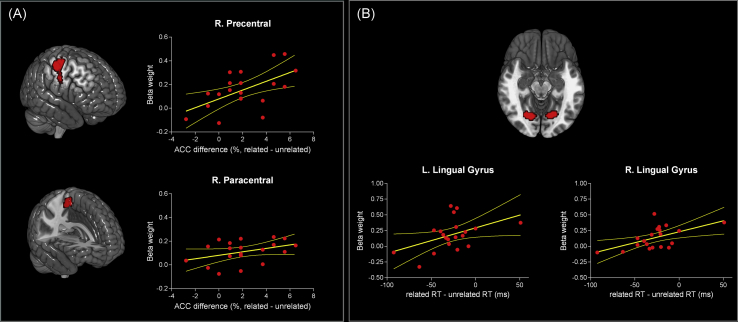
(A) The rendered images display the results of whole-brain search identifying regions more active for related, action-permitting object pairs, compared against unrelated objects. The scatter plots display the correlational relationships between β responses (extracted from the two active clusters of the right motor cortex) and the size of behavioural effect. (B) The rendered images display the results of whole-brain search identifying regions more active for related, object-scene composites, compared against unrelated stimuli. The scatter plots display the correlational relationships between β responses (extracted from the bilateral LG) and the size of behavioural effect. The thresholds were set at p < 0.005 at the voxel level and further constrained for cluster-level multiple-comparisons at p < 0.05.